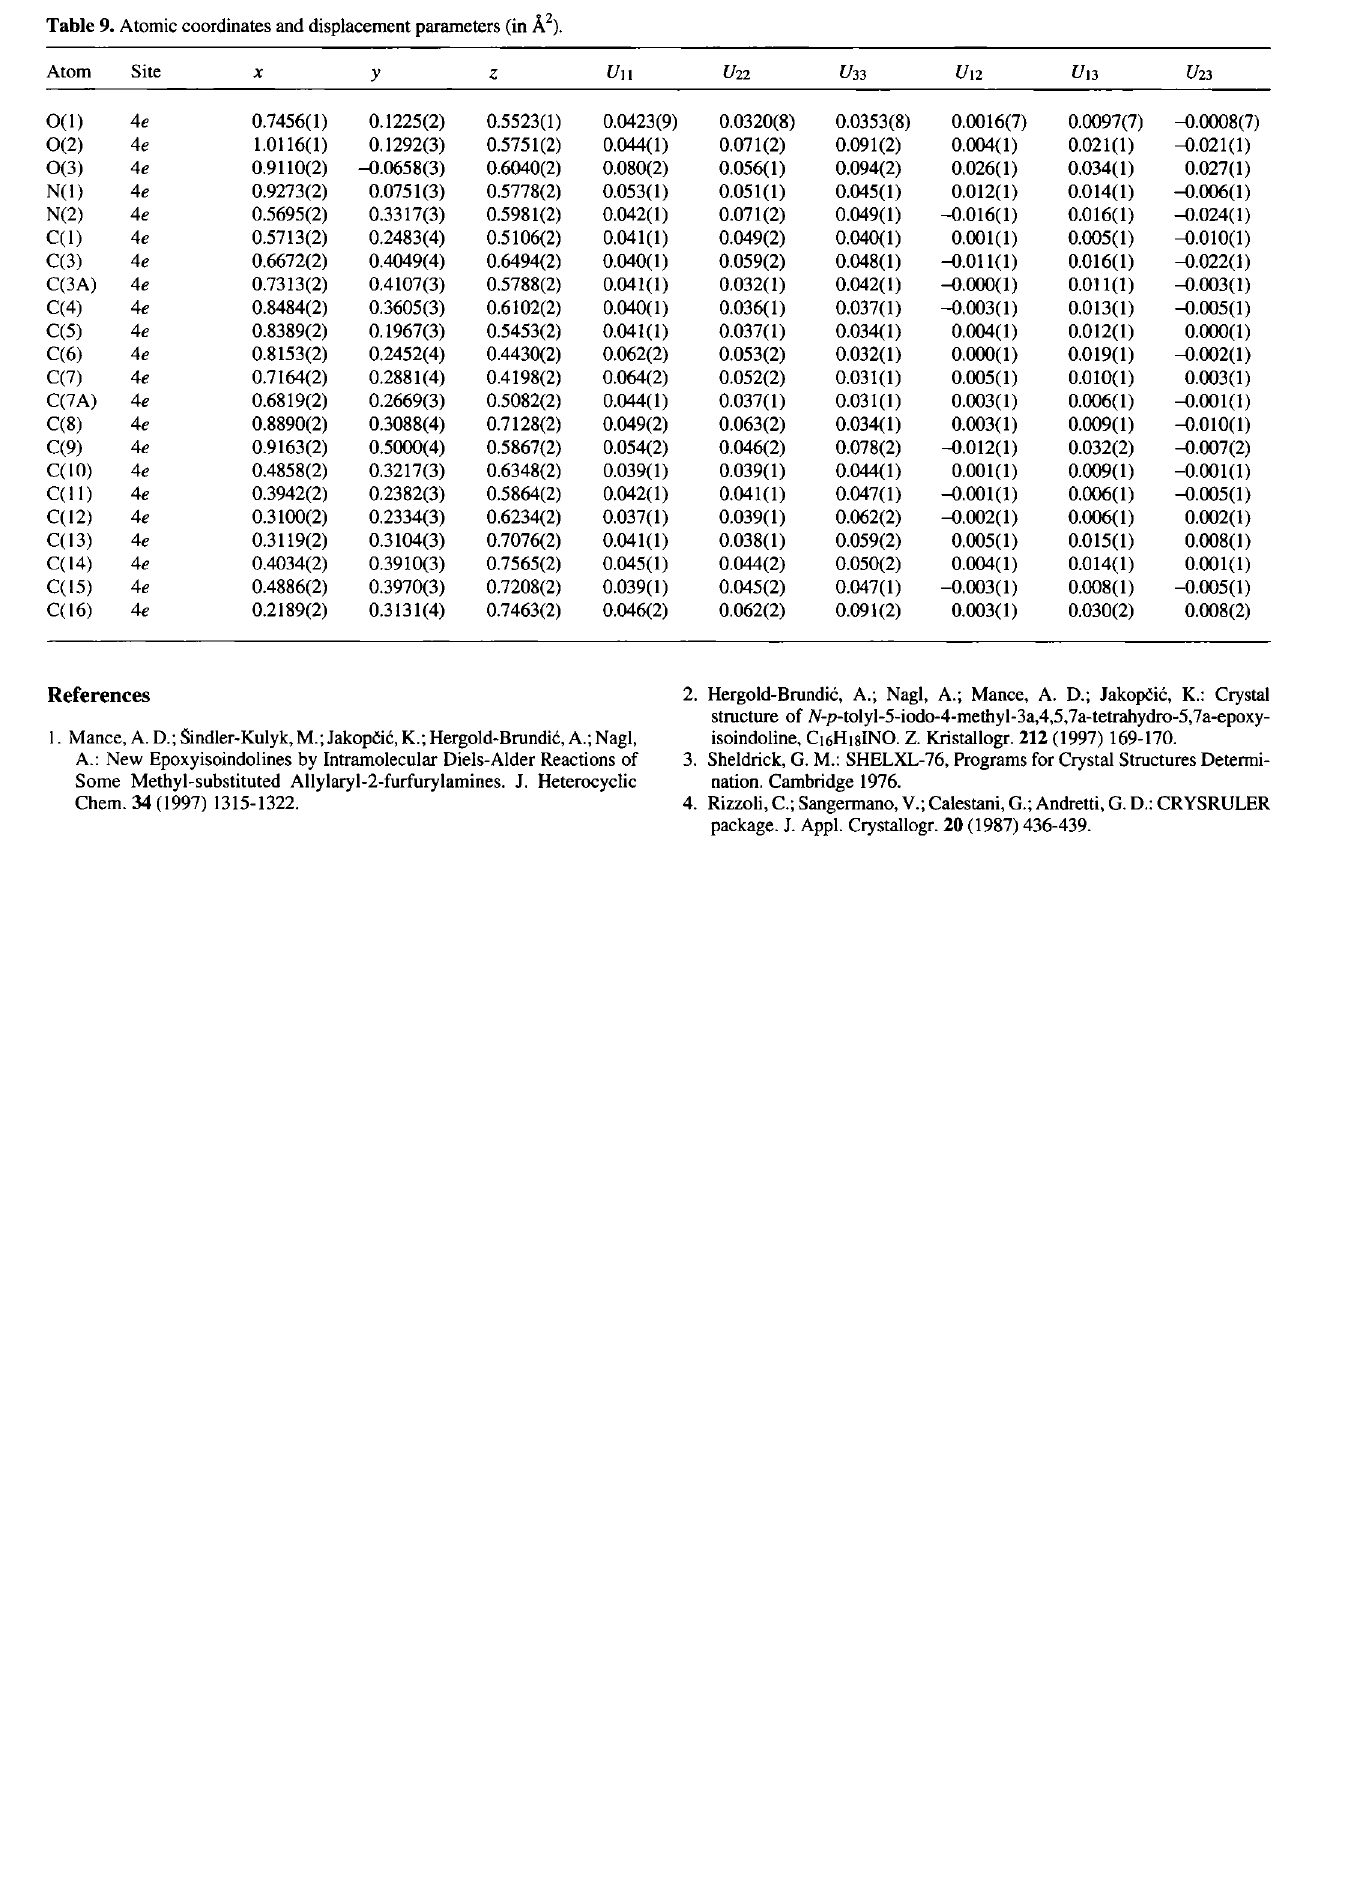
Table 9. Atomic coordinates and displacement parameters (in À 2